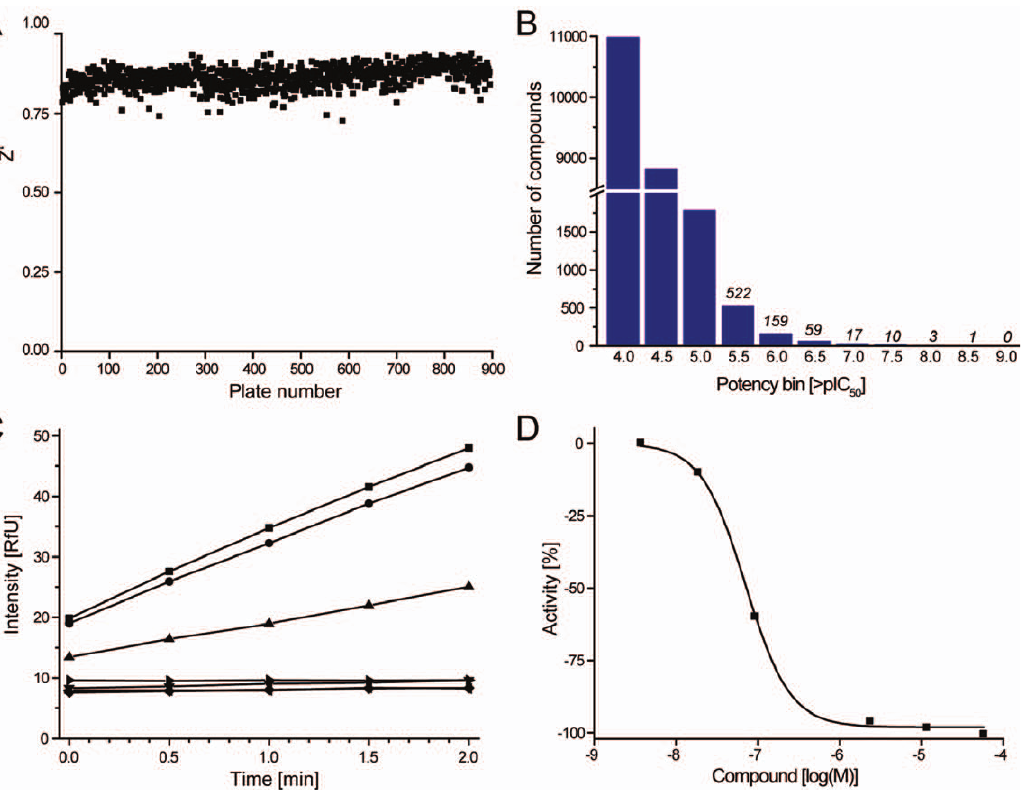
Figure 1. Quantitative high-throughput screen of 15-PGDH. A. Plot of the Z’ factor associated with each plate, showing high stability over the entire duration of the screen (completed in five days). The average Z’ was 0.86. B. Hit frequency for the library of tested compounds, measured as the distribution of compounds according to binned potencies. C. Typical effect of a non-fluorescent screening hit (inhibitor 13 , titrated between 3.5 nM and 57.5 m M) on the time course of NAD + -reduction upon addition of PGE 2 . D. Dose-dependent reduction in enzyme activity caused by compound 13 , as detected during the screen.